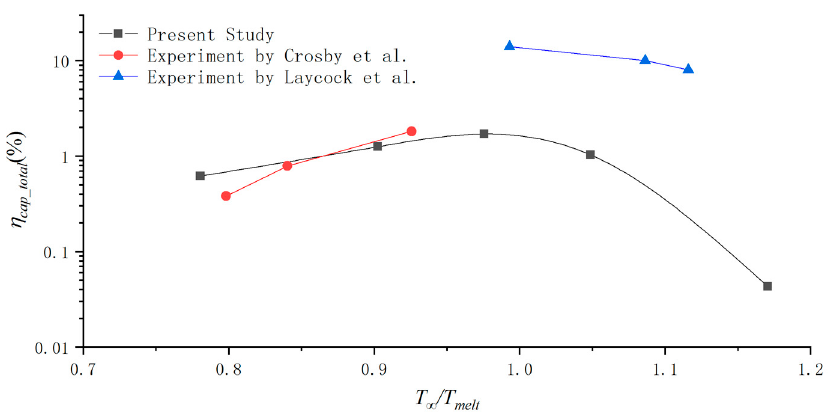
Figure 18. Capture efficiency with different mainstream temperature.